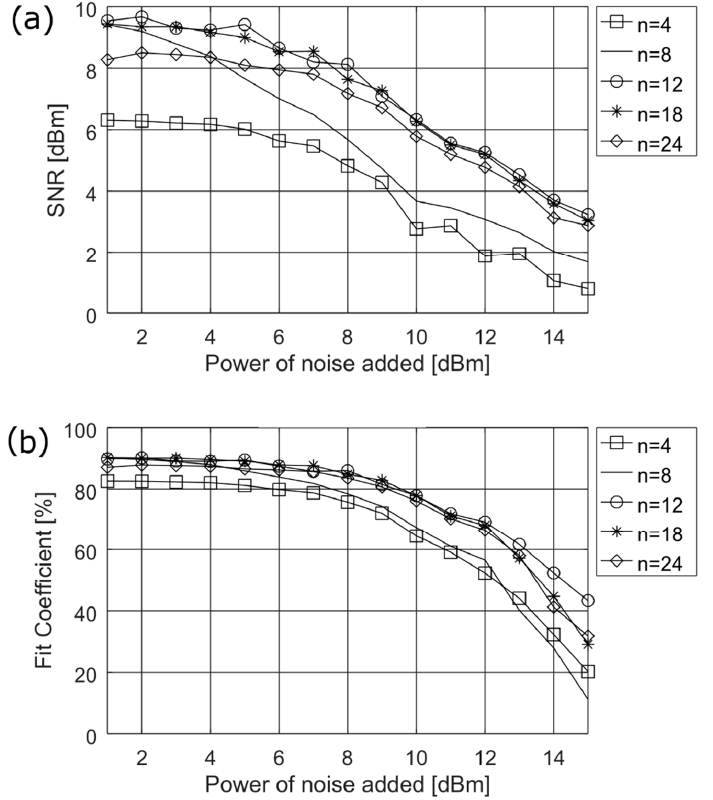
Figure 3. Simulation results obtained during determination of the optimum length for tapped delay line – N , ( a ) of SNR and ( b ) of fit coefficient .